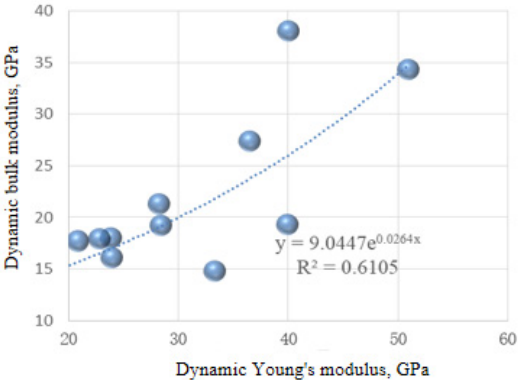
Figure 12. Distribution histogram of dynamic Young’s modulus and bulk modulus.